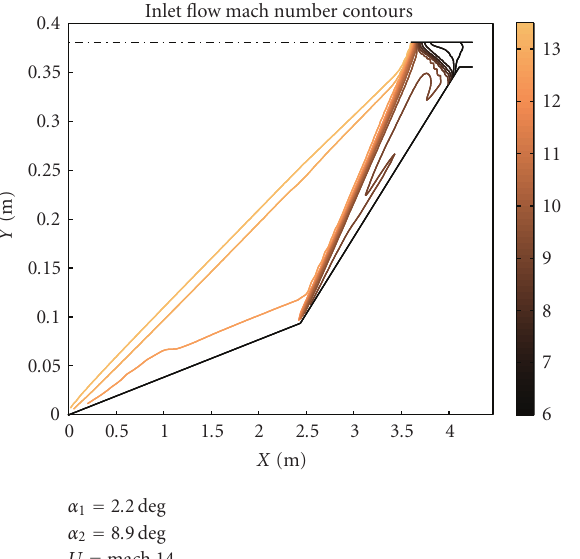
Figure 6: Mach contours of optimized cowl inlet. Inlet flow mach number contours